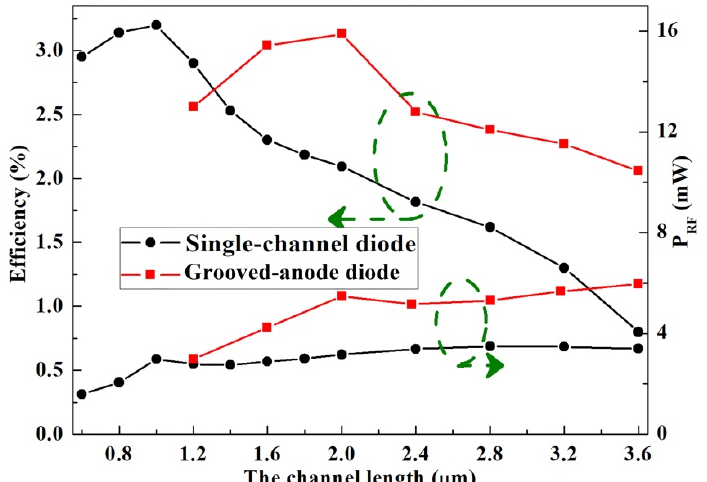
Figure 3. Variation of efficiency η with the channel length L and RF output power P AC with L in the grooved-anode diode and the variation of the single-channel diode.